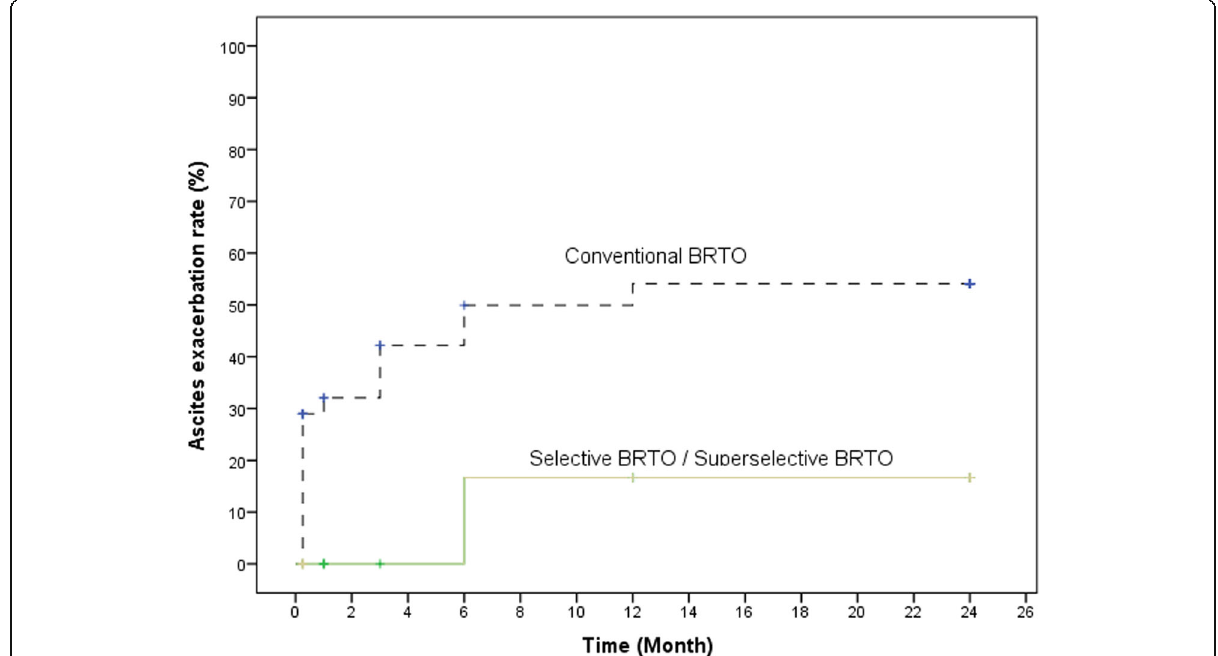
Fig. 6 Ascites exacerbation after conventional, selective, and superselective BRTO.Kaplan-Meier curves show that ascites exacerbation rates after conventional BRTO were significantly higher than both selective and superselective BRTO ( p = 0.03)